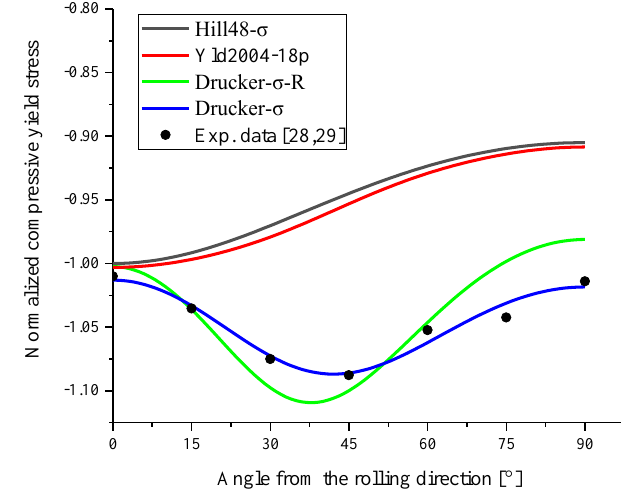
Figure 6. The normalized compressive yield stresses with four yield functions for AA 2008-T4 sheet.